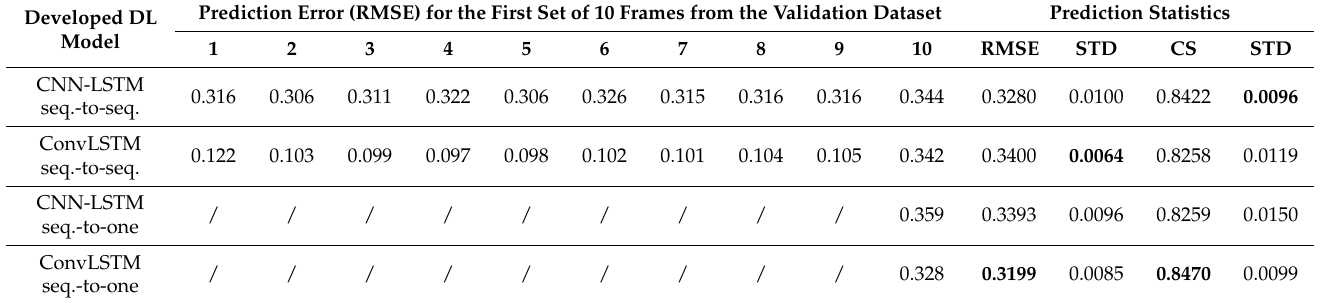
Table 1. Comparison of the prediction errors of the four developed DL models using the valida- tion